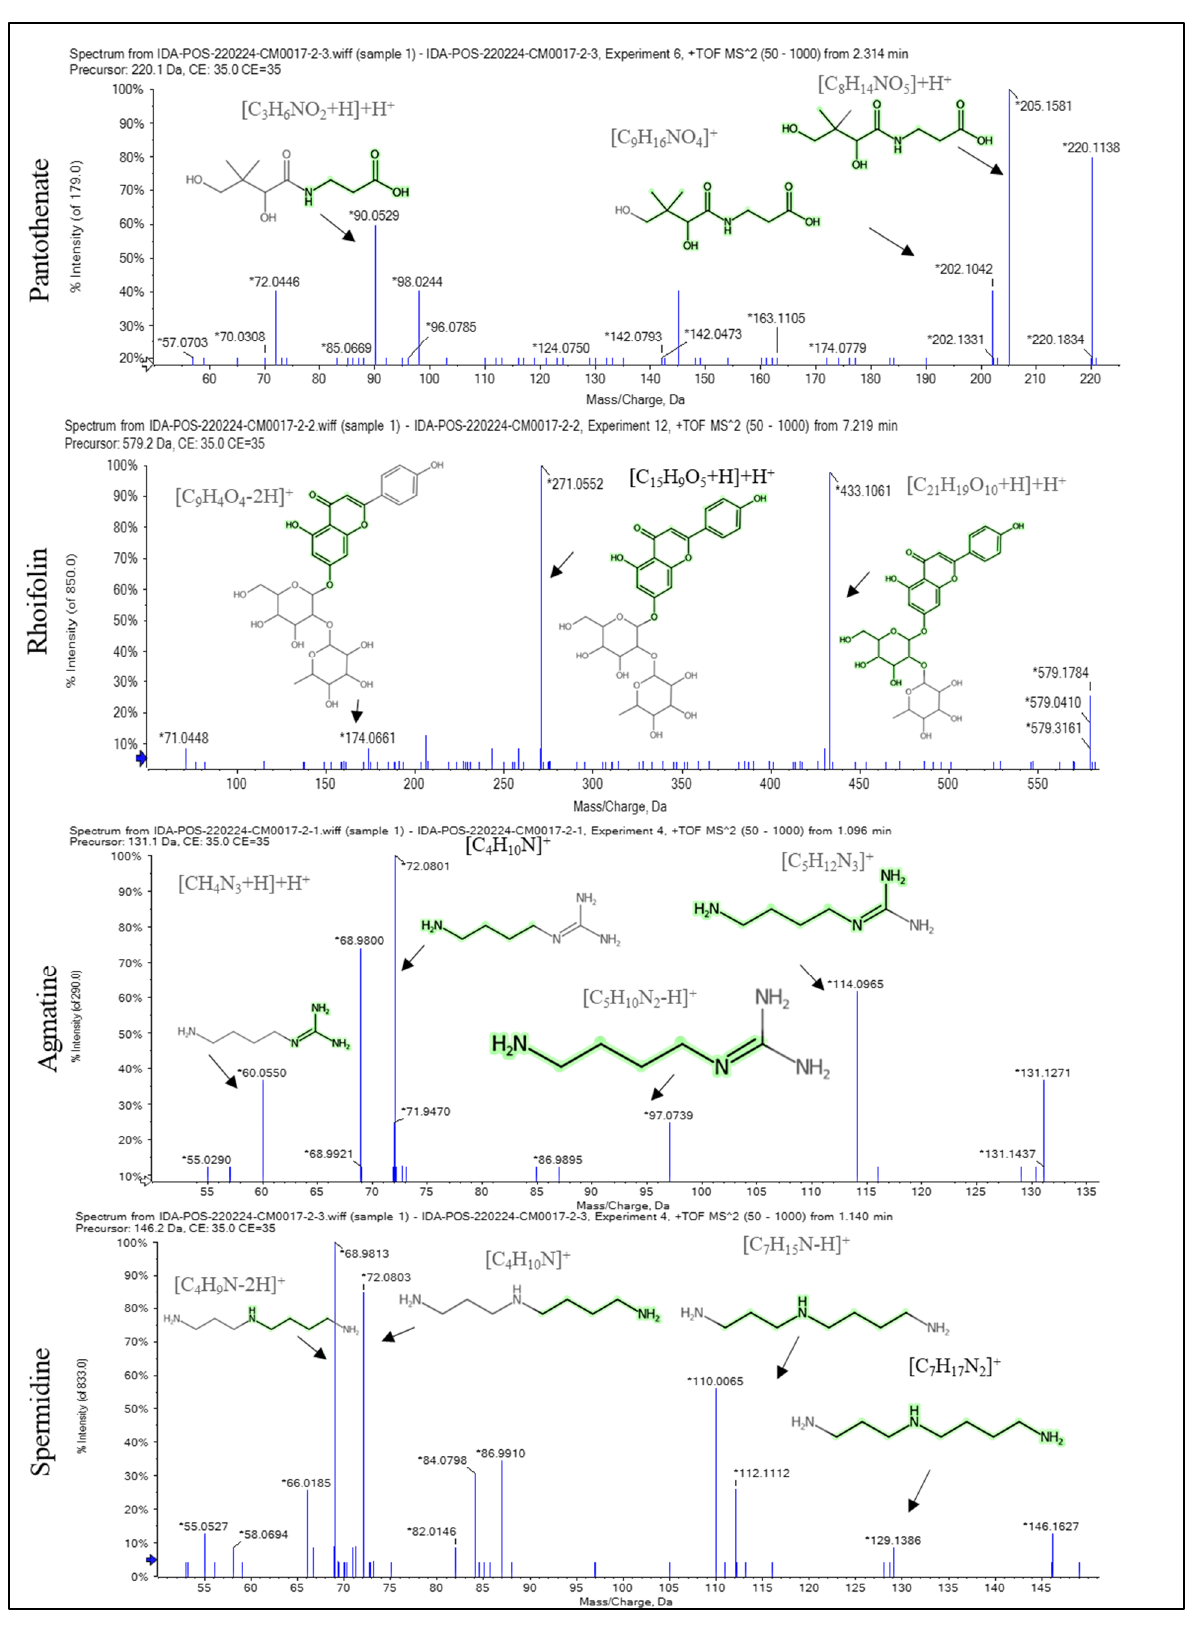
Figure 2. The fragmentation pattern of the main compounds recognized in the methanol extract of Salvadora persica stem bark: pantothenate, rhoifolin, agmatine, and spermidine. * stands for m/z of [M+H] + , [M-H] − , and fragments of each compound.